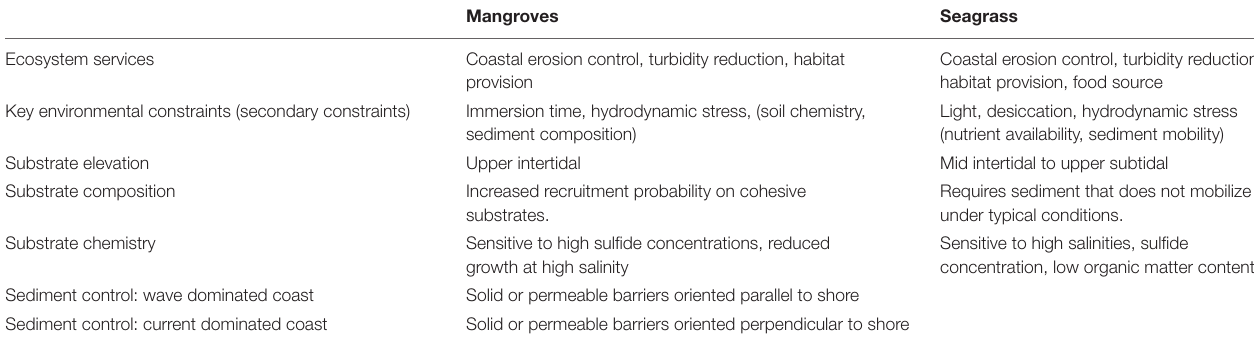
TABLE 1 | Summary of key considerations for creating new sediment substrates destined for mangrove and seagrass